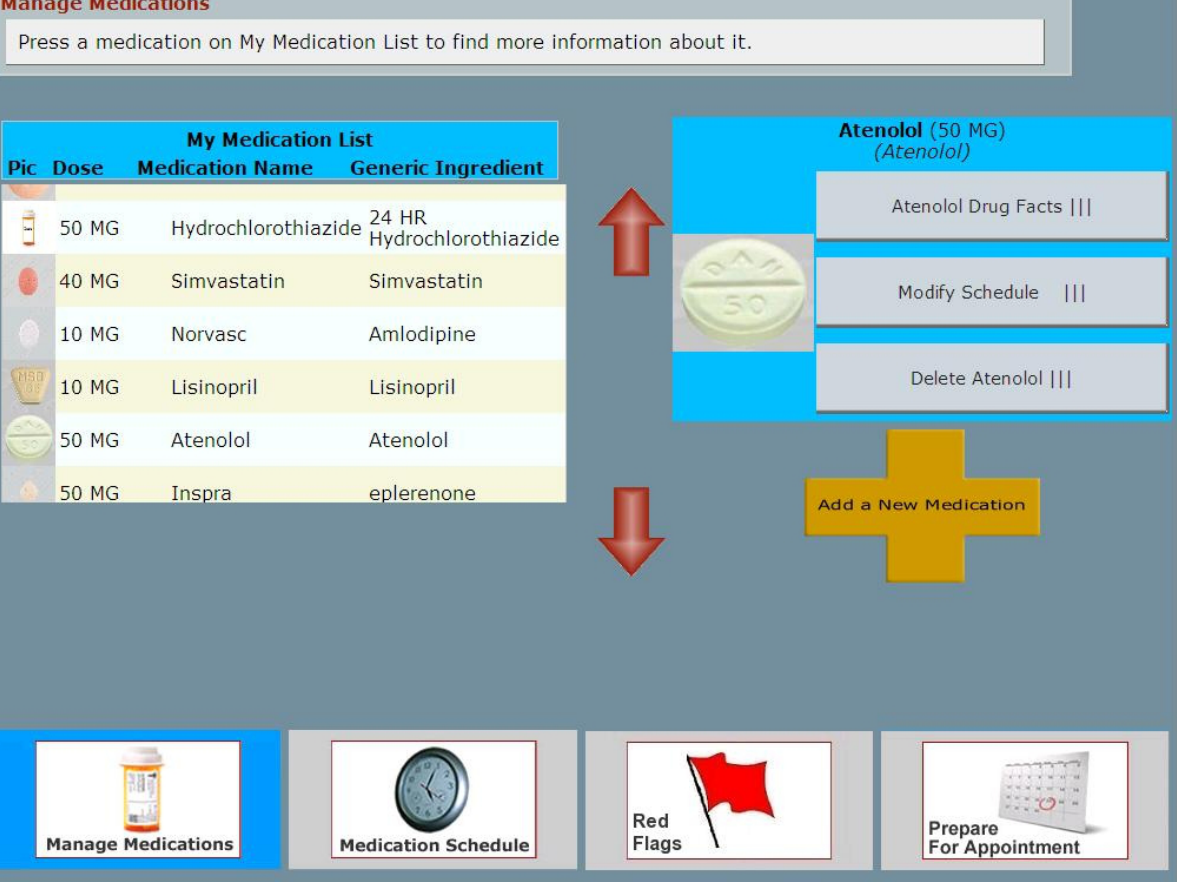
Figure 4. Dock navigation for Colorado Care